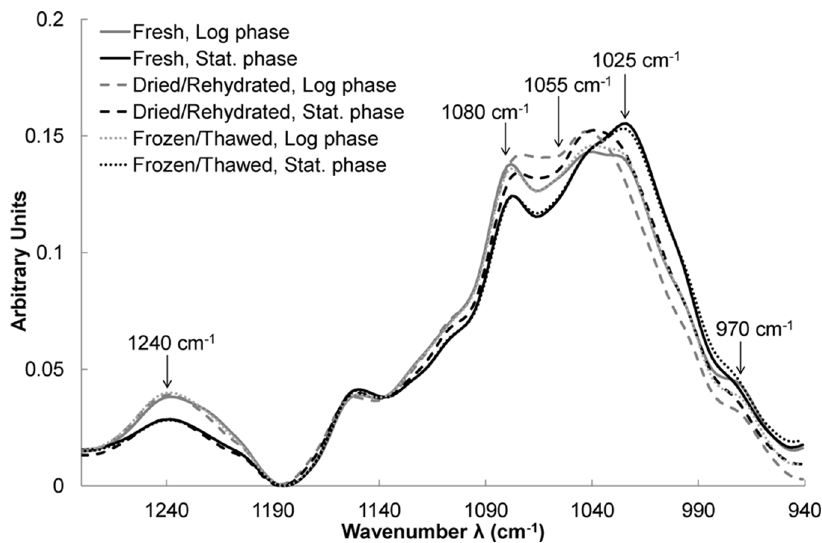
Figure 6. FT-IR analysis in the region of phosphate groups and carbohydrates before and after stabilization treatments. Averaged spectra in the 1280–940 cm 2 1 region of all spectra obtained for freshly harvested cells (solid lines) either in the log (gray lines) or stationary (black lines) phase and further dried/rehydrated (dashed lines) or frozen/thawed (dotted lines). Spectra have been baseline offset and vector-normalized before being averaged.